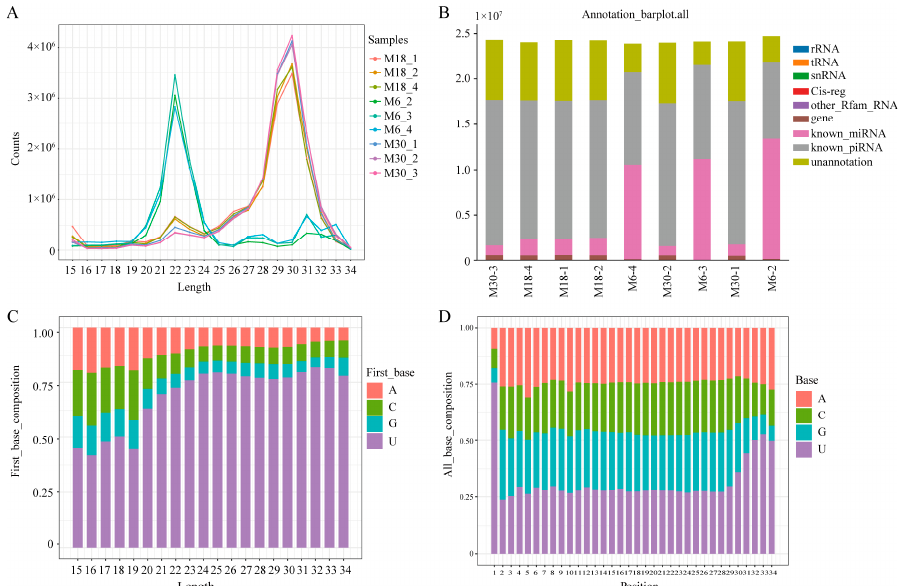
Figure 1. Characterization of piRNAs present in the yak testis. ( A ) Length distribution of the small RNAs identified with small RNA sequencing; ( B ) category of small RNA with uniq-clean reads from the small RNA sequencing; ( C ) visual diagram of the preference of the first base of piRNAs with different lengths; ( D ) visual diagram of base bias at each site of the piRNA sequence.